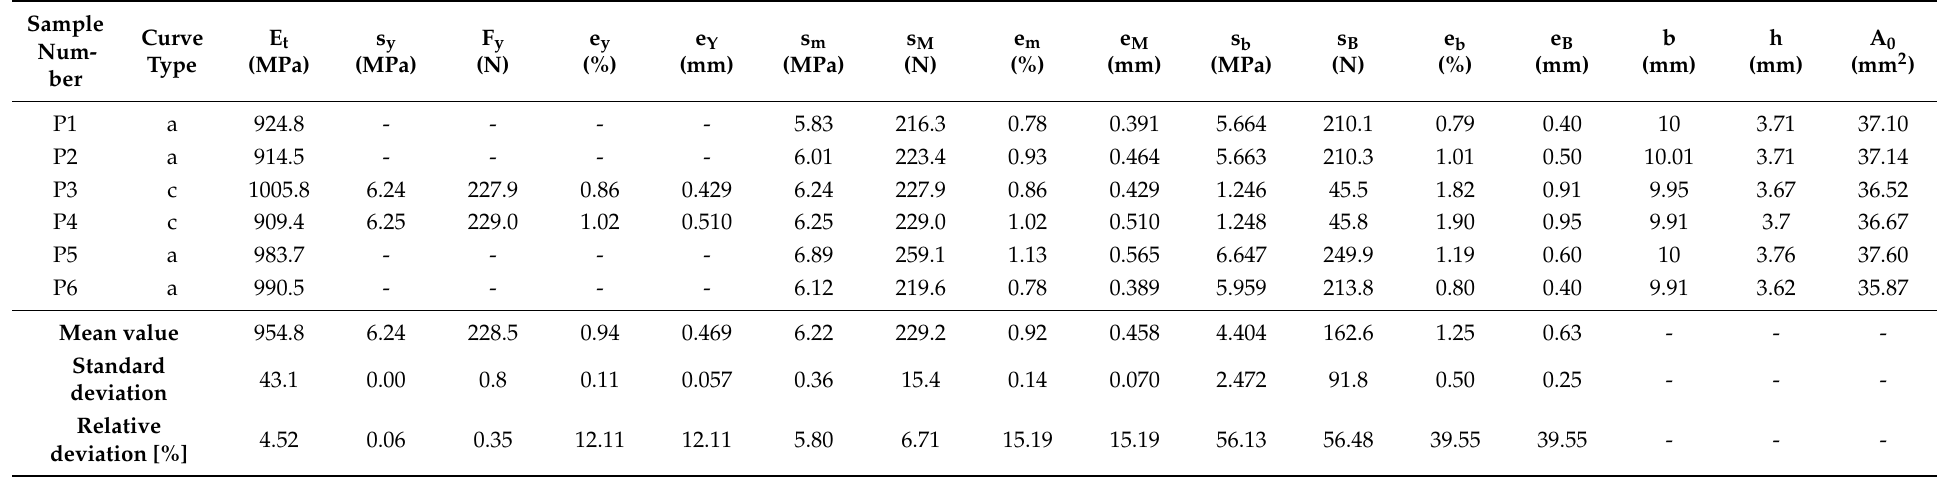
Table A34. Results of the tensile tests of P_PS.